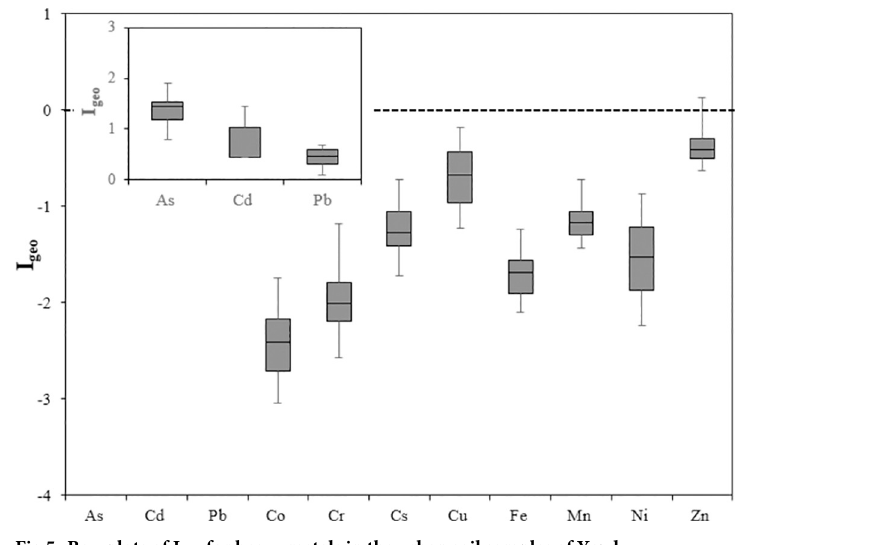
Fig 5. Box-plots of I geo for heavy metals in the urban soil samples of